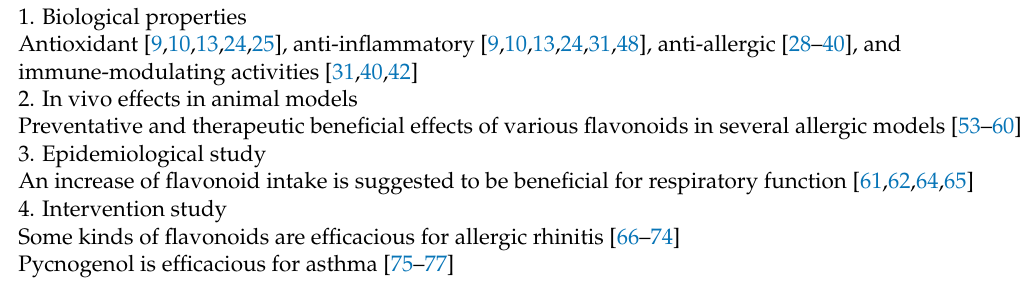
Table 3. Summary of the anti-allergic effects of